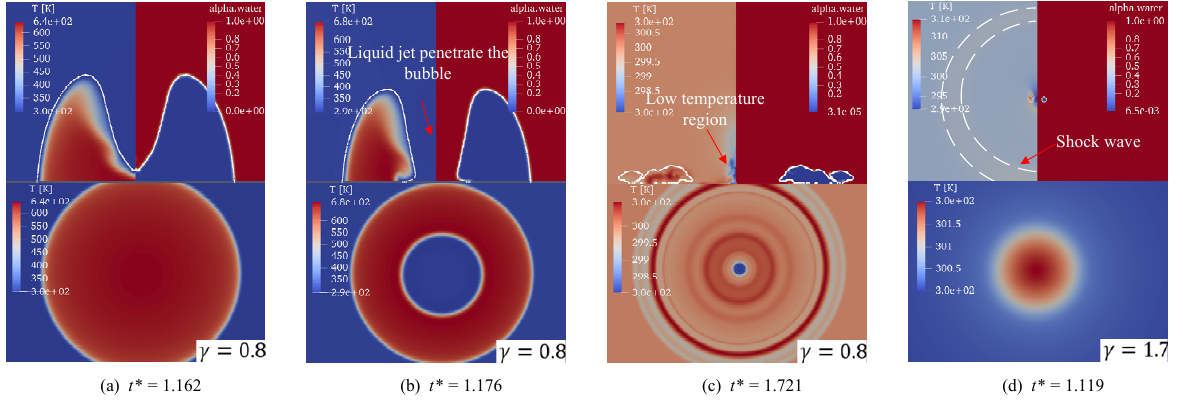
Figure 6. Transient evolution of numerical bubble shapes ( right-hand side), temperature distributions ( left-hand side), and wall temperature distribution ( bottom ) at different times and different stand-off distances during the multi-period evolution of bubbles. ( a ) γ = 0.8, t * = 1.162, ( b ) γ = 0.8, t * = 1.176, ( c ) γ = 0.8, t * = 1.721, ( d ) γ = 1.7, t * =